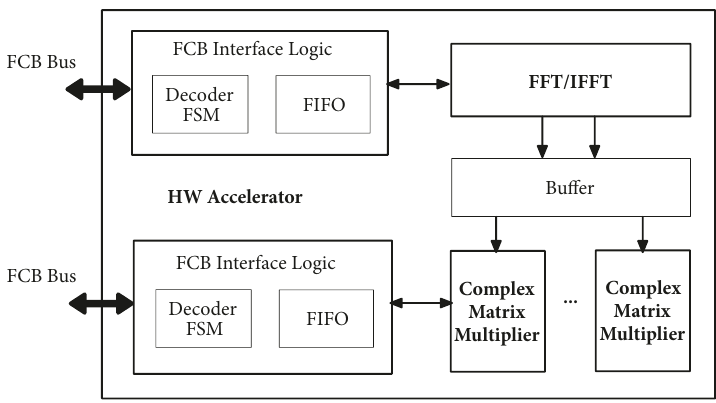
Figure 4: Block diagram of the hardware